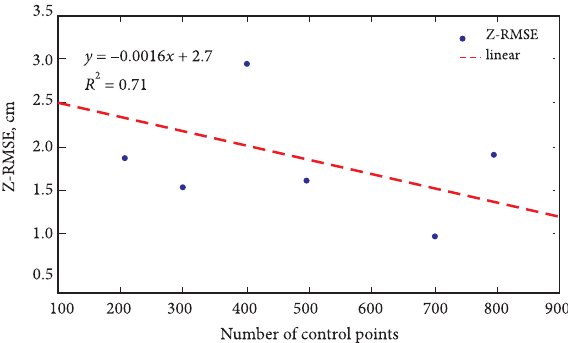
Fig. 9. RMSE (Height) changing rate by increasing control points